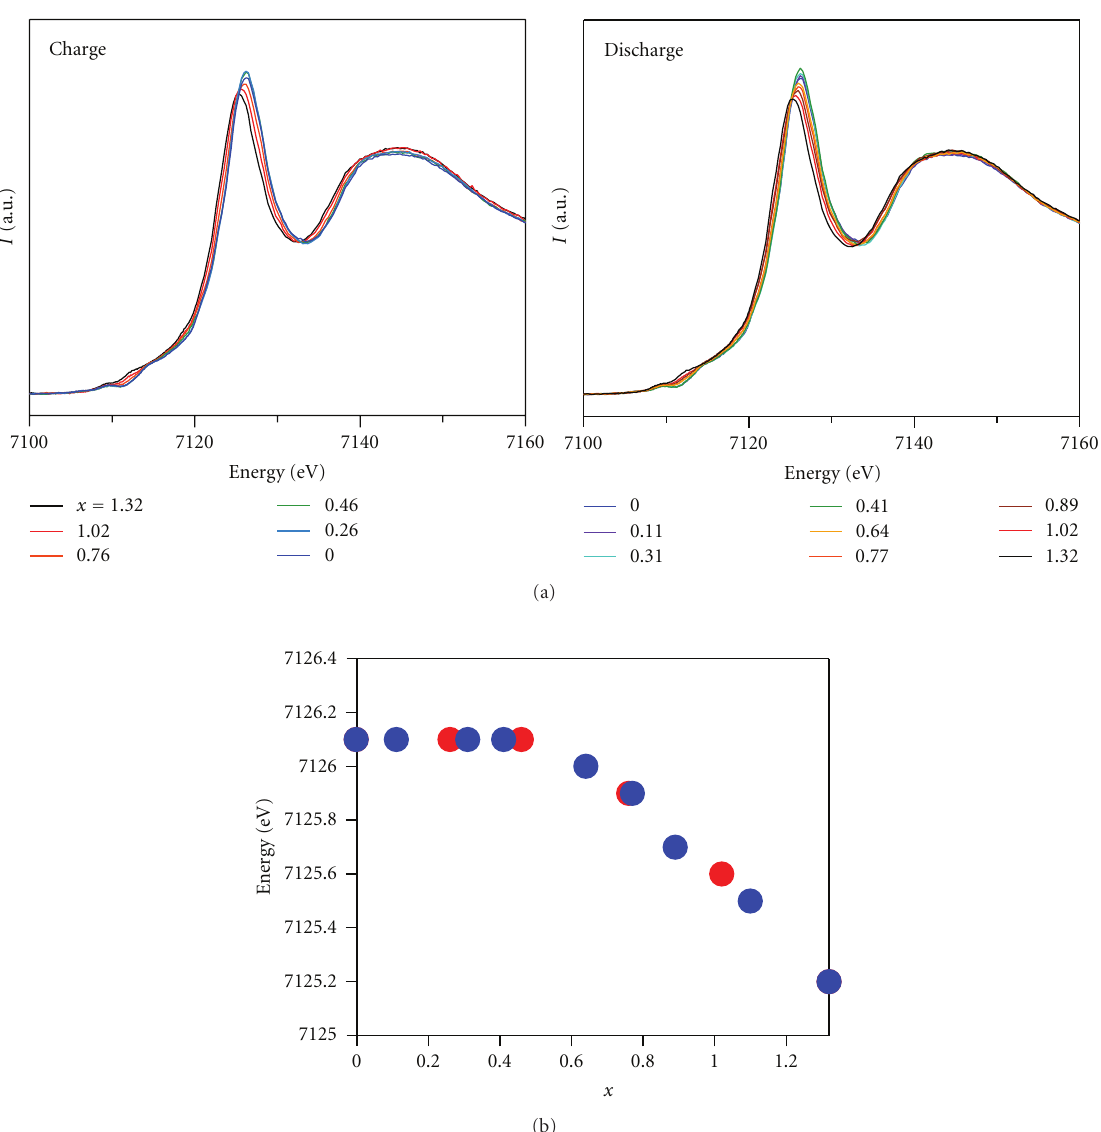
Figure 4: (a) Fe K-edge XAS spectra for the charge (left) and discharge (right) processes of film-type electrode of Li x Mn[Fe(CN) 3 . 5H 2 O. (b) Peak energy ( E ( x )) against x for the charge (red) and discharge (blue) processes.